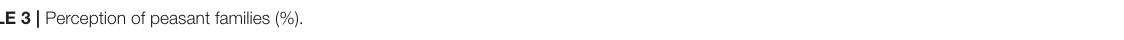
TABLE 3 | Perception of peasant families